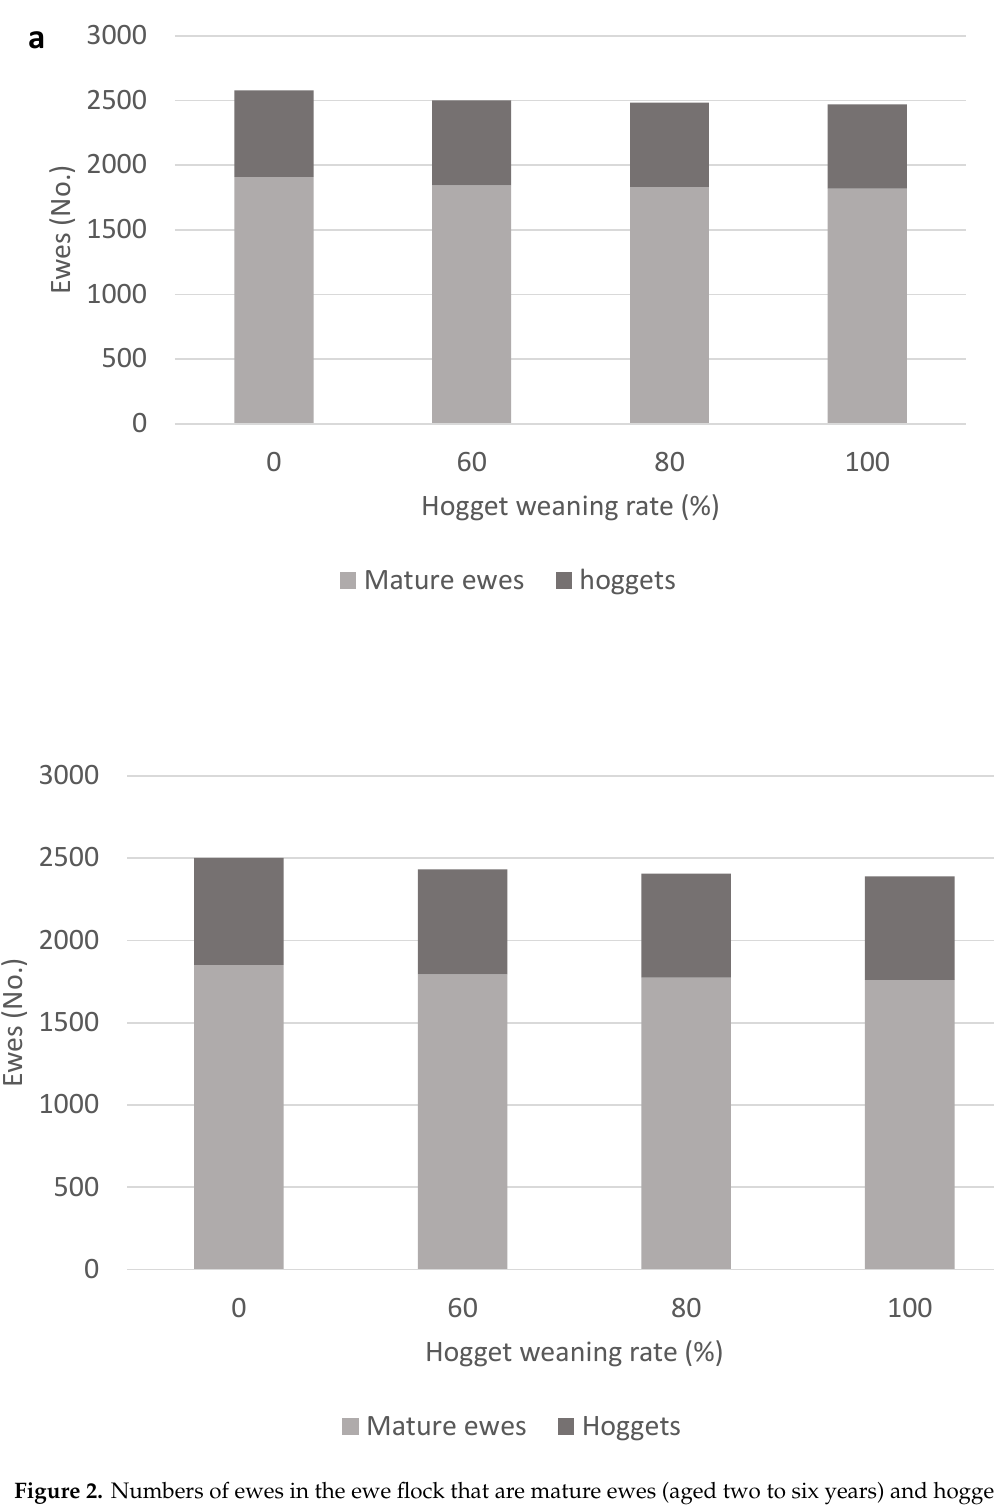
Figure 2. Numbers of ewes in the ewe flock that are mature ewes (aged two to six years) and hoggets, with varying hogget weaning rates and with mature ewe weaning rates of ( a ) 132% and ( b ) 150%.